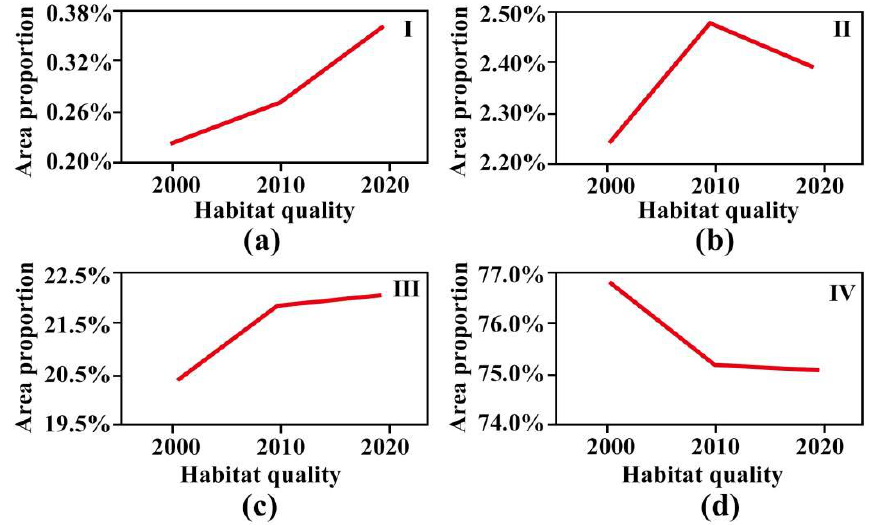
Figure 7. Changes in the different levels of habitat quality: (a) Level Ⅰ (b) Level Ⅱ (c) Level Ⅲ (d) Level Ⅳ (1) Terrain position calculation